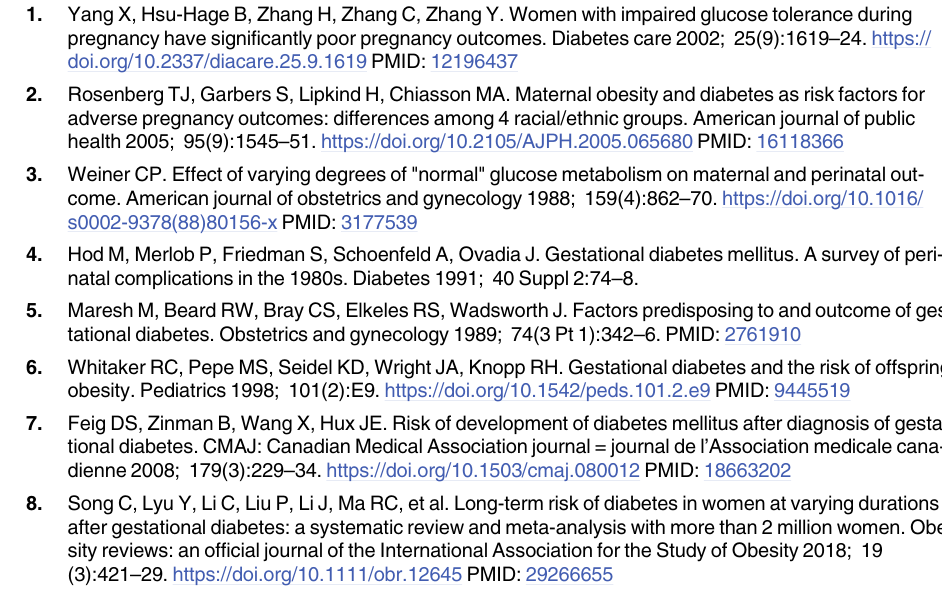
S2 Table. Costs associated with routine surveillance, obstetric and neonatal complications due to gestational diabetes, per study participant, by study arm. All costs were reported